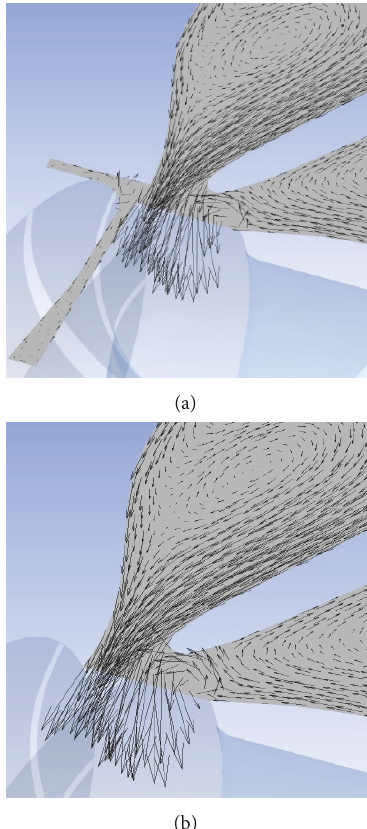
Figure 22: Velocity vectors in a volute cross section for partial hub admission (a) with backside cavity and (b) without it.